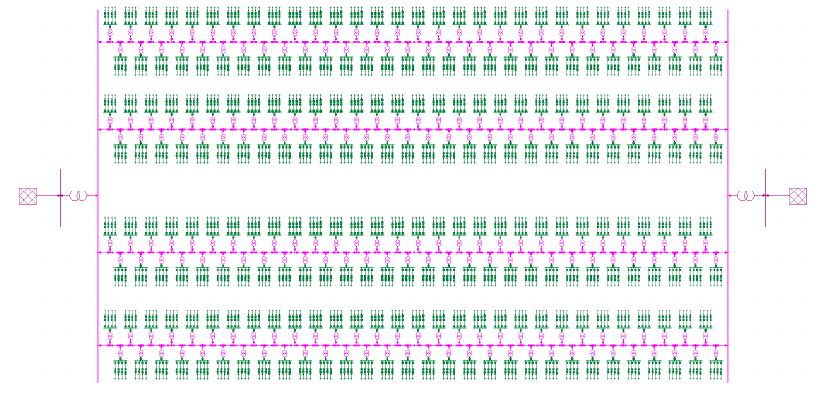
Figure 2. Test-Network. Figure 2.